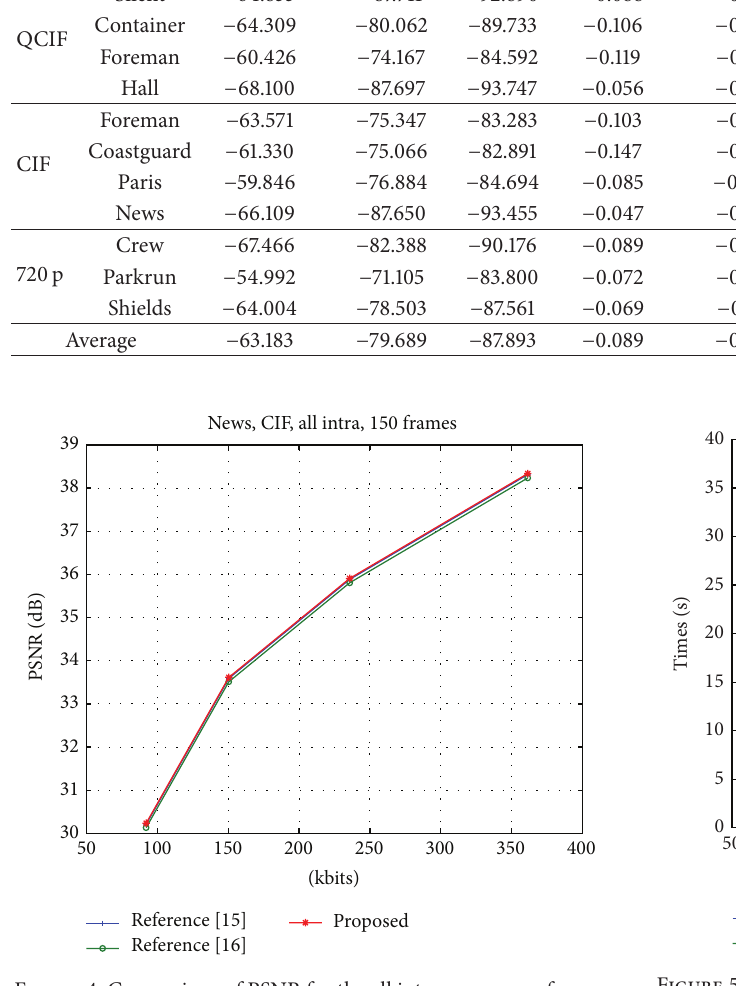
Figure 4: Comparison of PSNR for the all intrasequences of news.